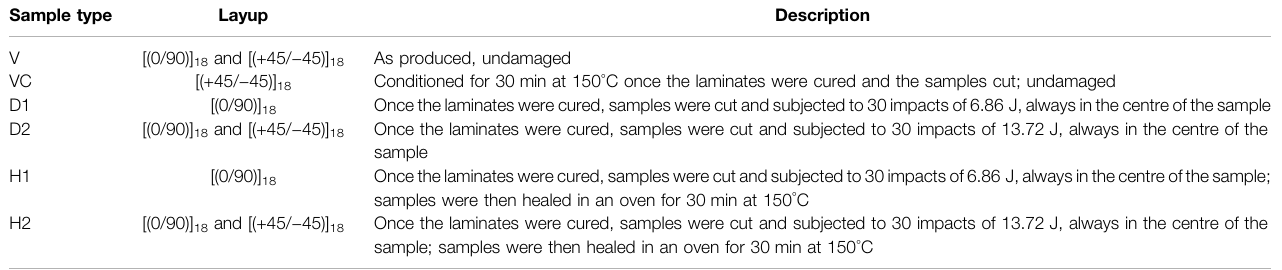
TABLE 1 | Description of the different types of analyzed and tested samples. Sample type